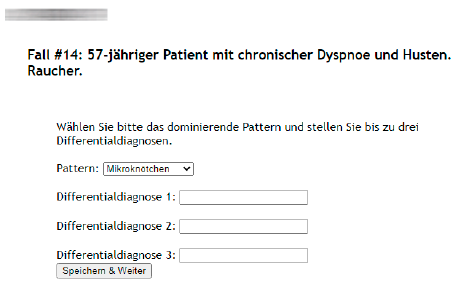
Figure 1. Example of a web-based case presentation and answer sheet featuring a short patient history consisting of age and sex as well as cardinal symptoms and relevant information (e.g., 57-year-old male with chronic dyspnea and coughing, smoker).